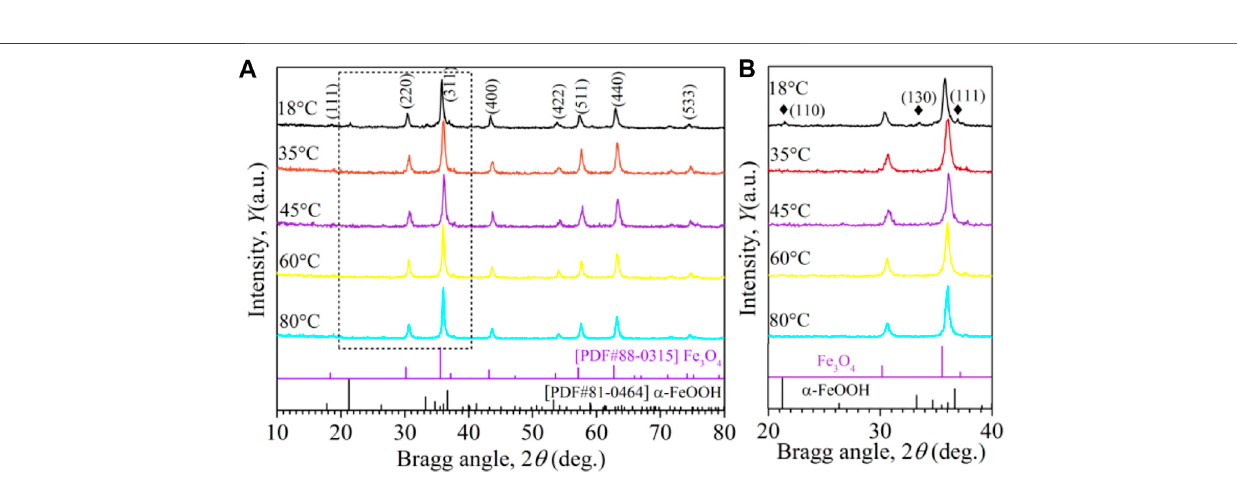
Frontiers in Energy Research |